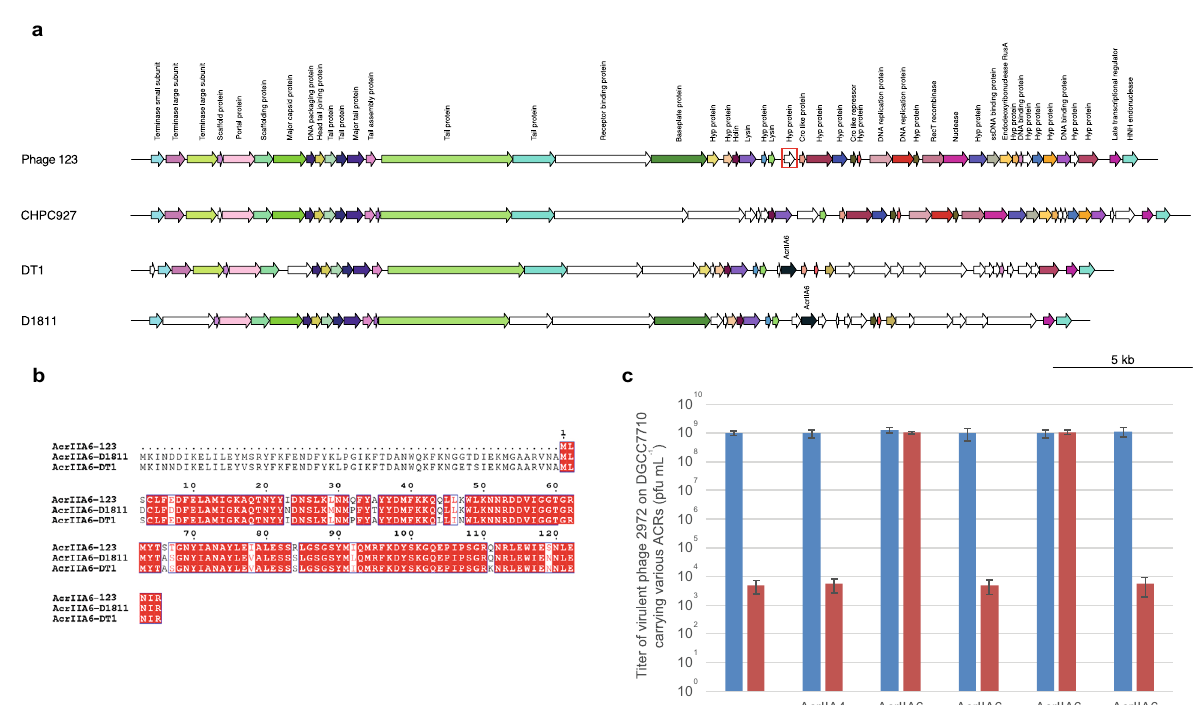
Fig. 2 The truncated AcrIIA6 of phage 123 inhibits spacer acquisition but not CRISPR interference. a Genome architecture of phage 123 and its relatedness to a few other S. thermophilus phages. ORFs that share over 80% amino acid identity are colored. The most closely related phage is CHPC927. The position of the truncated acrIIA6 gene on the phage 123 genome is indicated by a red square. b Sequence alignment of AcrIIA6 variants reveal a deletion of the fi rst 59 amino acid residues in AcrIIA6 123 as compared to previously characterized full-length AcrIIA6 from other phages. c Titer of phage 2972 on its host strain S. thermophilus DGCC7710 or on a CR1-immune derivative (SMQ-1335b), carrying either the empty vector pNZ123 or the vector expressing AcrIIA4 (inactive in S. thermophilus ) or functional AcrIIA6 alleles. Resistance to phage 2972 by CRISPR interference was observed in the control (empty vector), with AcrIIA4, with AcrIIA6 123 and with a truncated version of AcrIIA6 D1811 (AcrIIA6 D1811- Δ 59 ). Each column shows the average of three biological replicates and each of two technical